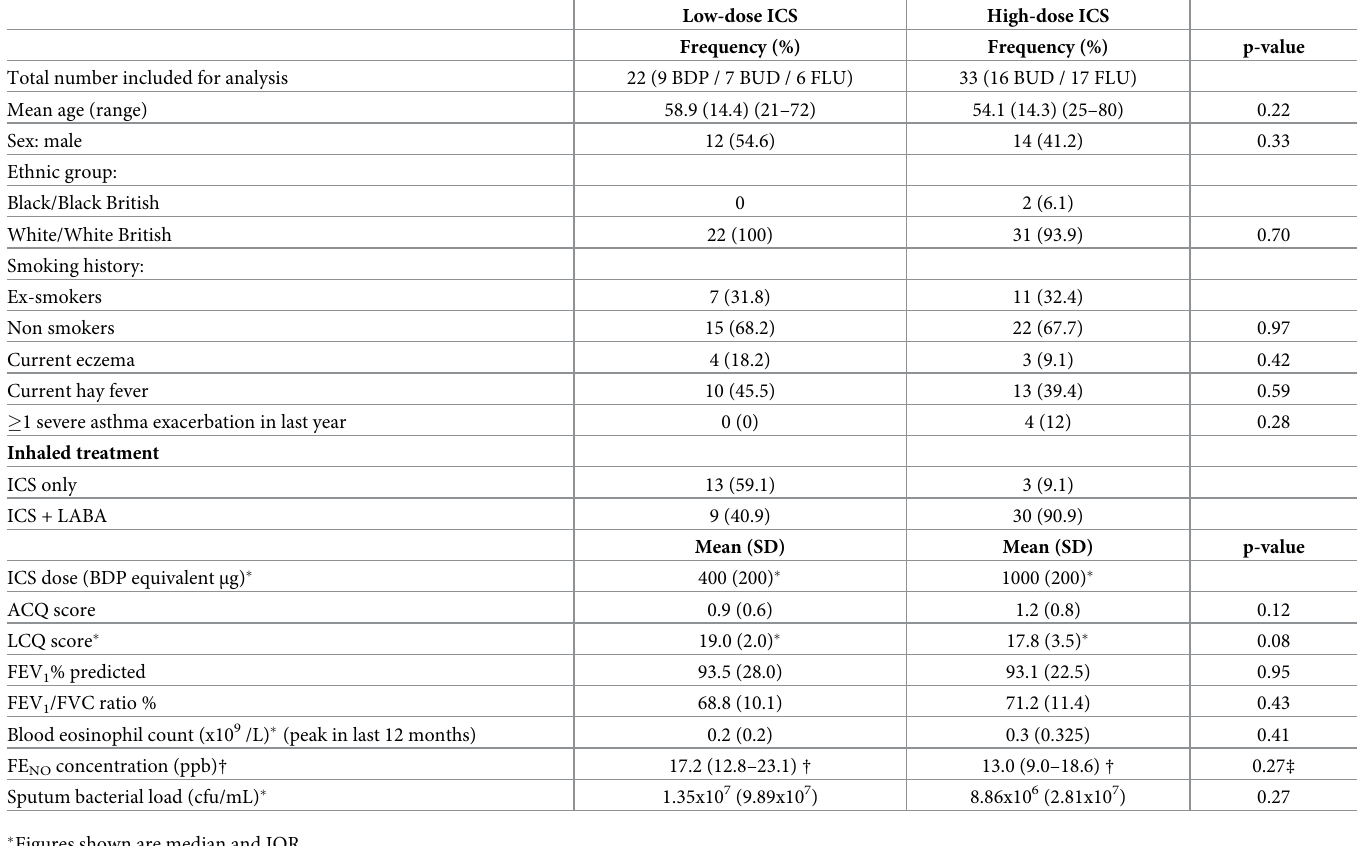
Table 1. Study participant